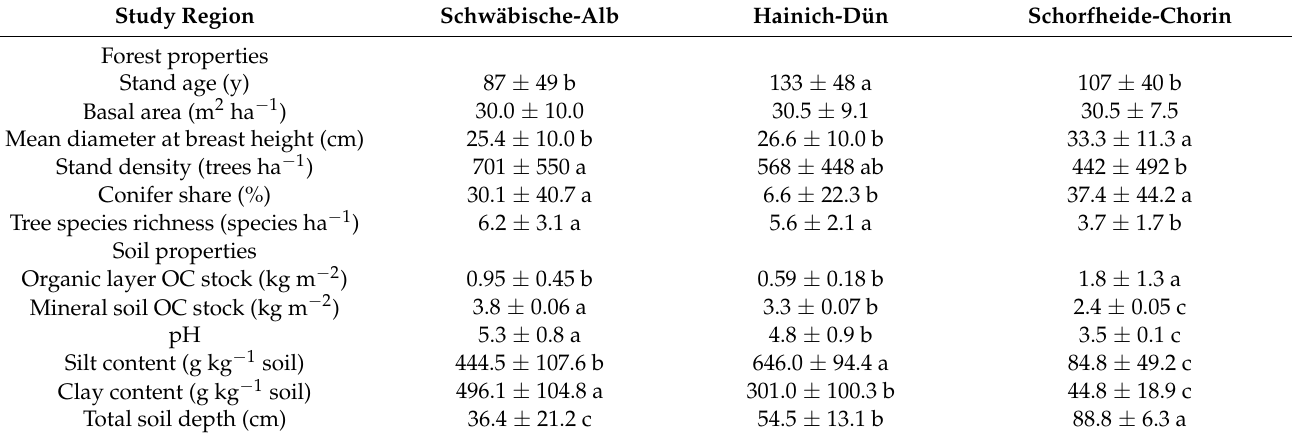
Table 2. Forest and soil properties for the three study regions. Regional mean values and standard deviations are given. Names and units are given in the first column where the ‘-’ represents coefficients or count data. Lower case letters indicate significant differences ( p -value < 0.05) between study